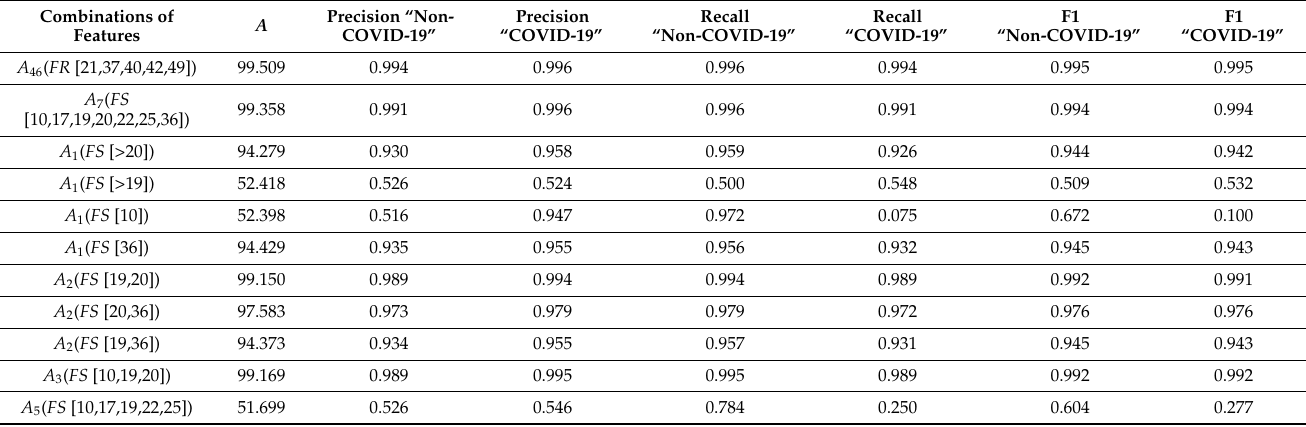
Table 7. LogNNet efficiency for various combinations of features.